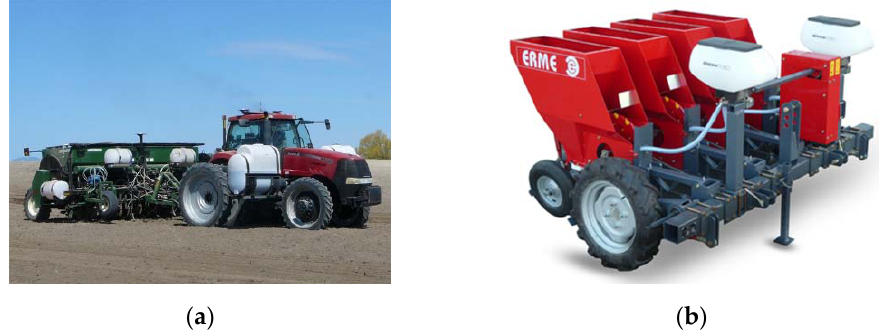
Figure 15. Pneumatic-type potato planter. ( a ) Lockwood 606. Reprinted with permission from ref. [83]. Copyright 2021 Crary Industries; ( b ) PLMS 4 rows. Reprinted with permission from ref. [84]. Copyright 2020 Engineering & Manufacturing Aircraft Tools.